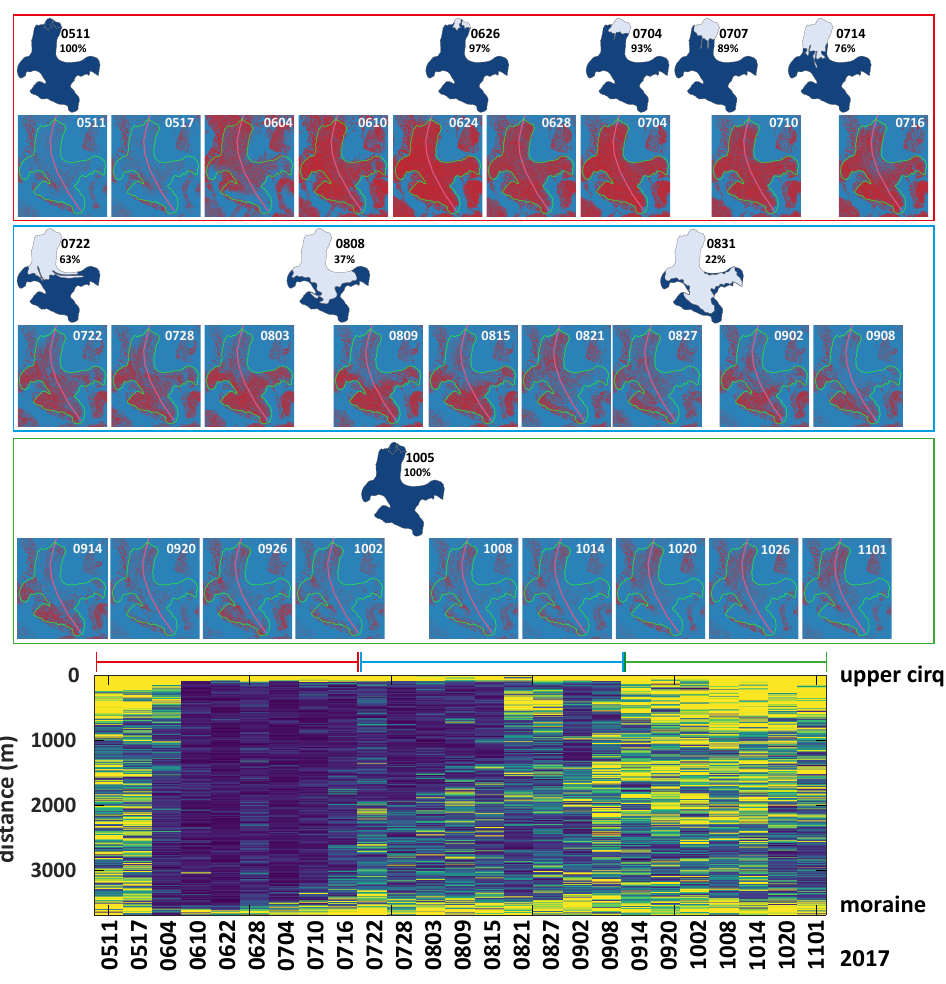
Figure 4. Comparison of the microwave reflectivity map (blue for strong reflected power associated with dry snow and ice, red for low reflectivity associated with wet snow) over the Austre Lovén glacier, with oblique-view fractional snow cover maps resulting from oblique-view image processing ( top row ). Bottom : evolution of the reflectivity along the central line (pink line on each RADAR map) at the same date as each Sentinel-1 RADAR map. The highest cirque is at distance 0 and the moraine at distance 3500 m, with the snow–ice limit altitude rising during the melt season as observed with the progression from low reflectivity (blue, wet snow) to high reflectivity (yellow, dry snow and first and later dry ice). The color coding over the bottom map matches the frame color around each RADAR